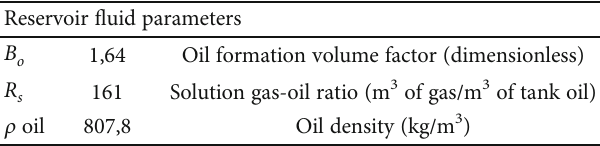
Table 1: Properties of the bottom hole fl uid sample collected in one of the wells in the study area [31,